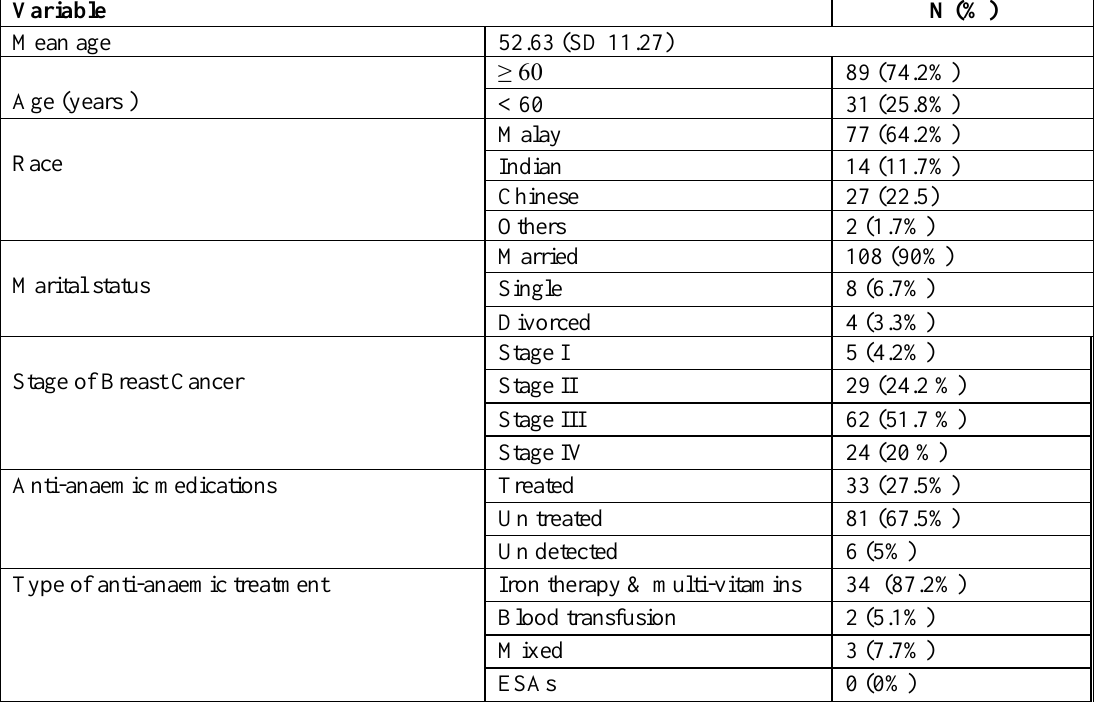
Table 1 Demographic data in breast cancer patients undergoing chemotherapy (N= 120)